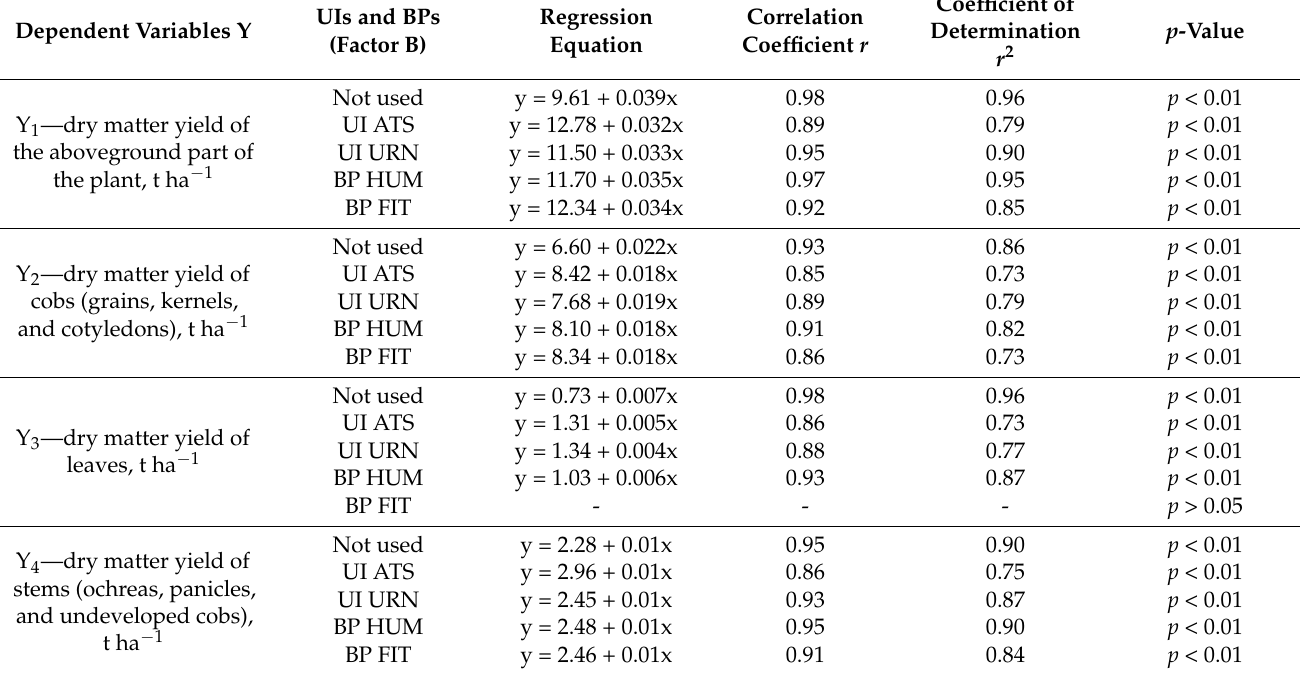
Table 12. Dependence of maize productivity on nitrogen fertilizer rates (factor A: x—kg ha − 1 ) in